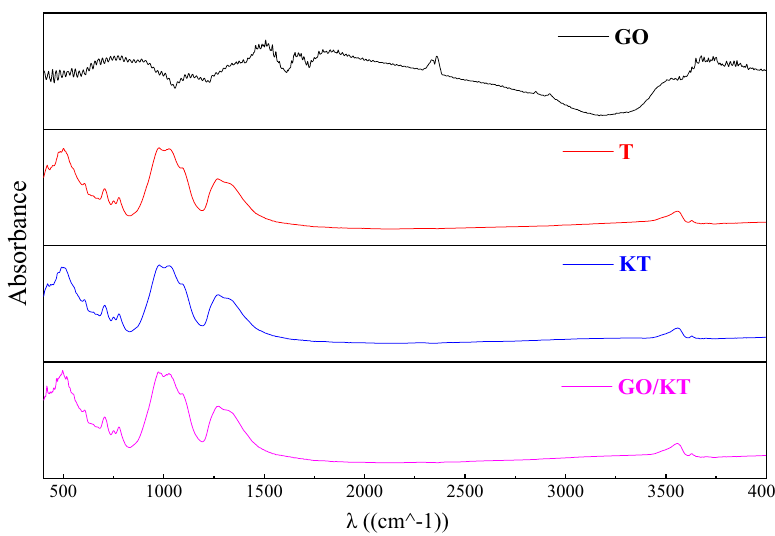
Figure 12: Infrared emission spectrum of di ff erent